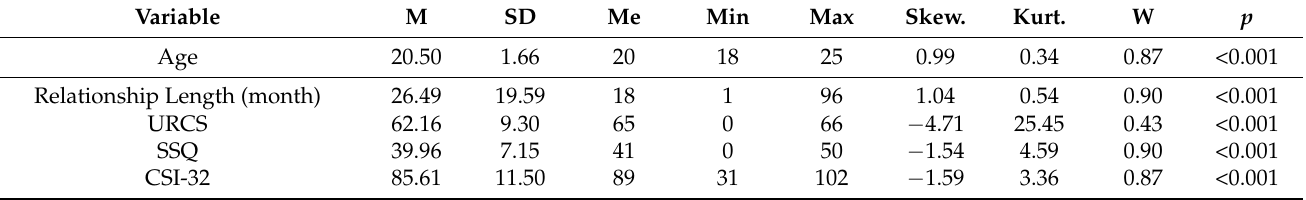
Table 1. Descriptive statistics and normality tests for psychological factors with Shapiro–Wilk